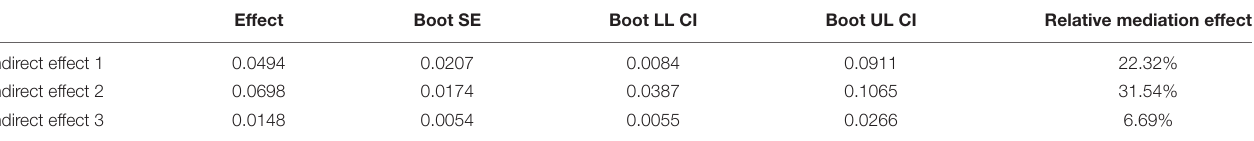
TABLE 2 | Bootstrap analysis of the mediation effect